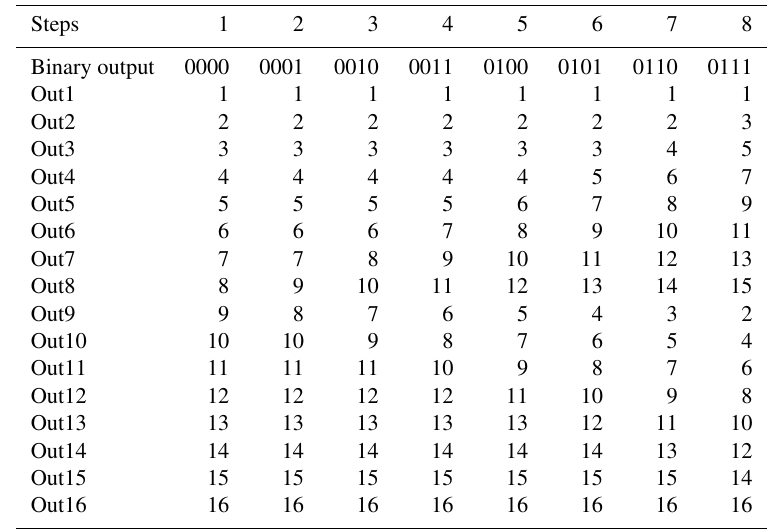
Figure 12. Simulation of adaptive coincidence detection (ACD). It shows the concept of ACD. The timing of the generated output spike depends on the difference between the input pulses. When there is a considerable difference, then there will be no spike at the output. Table 1. ASRC output spike orders for the first eight